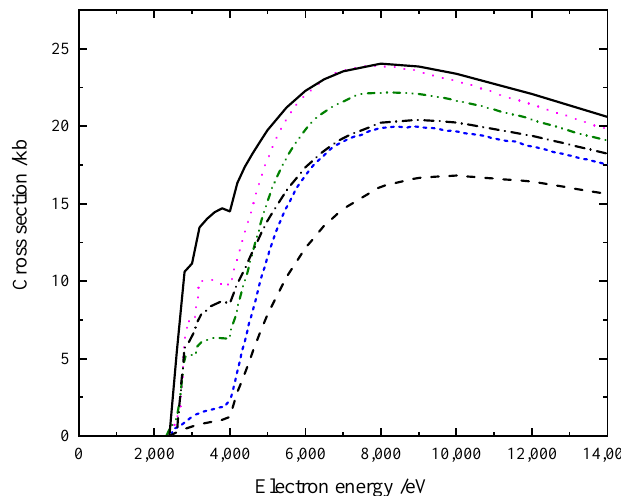
Figure 4. Accumulated EA cross-sections of ground state W 45 + . The shadow areas show contributions from different subshells (1.0 kb = 10 − 21 cm 2 ).